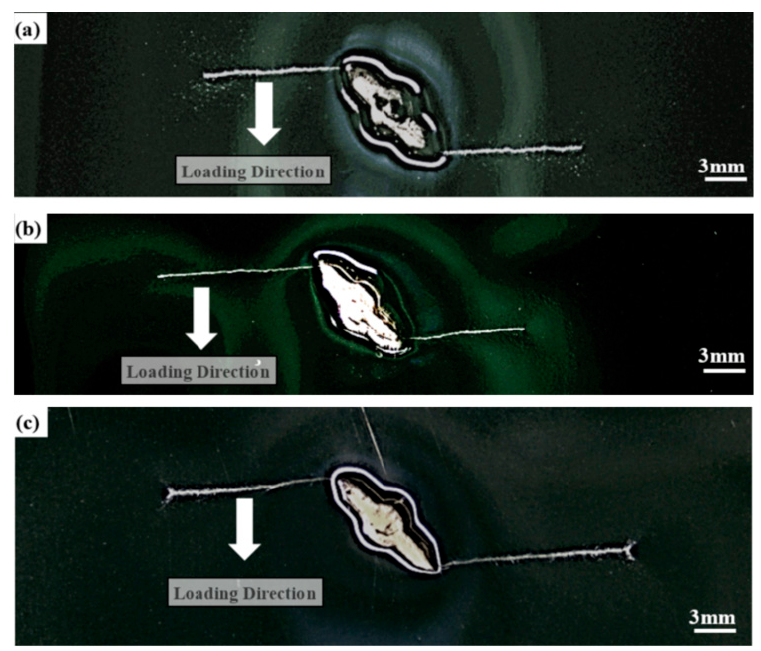
Figure 5. Crack propagation paths: ( a ) the BM specimen; ( b ) the HAZ specimen; and ( c ) the WM specimen.